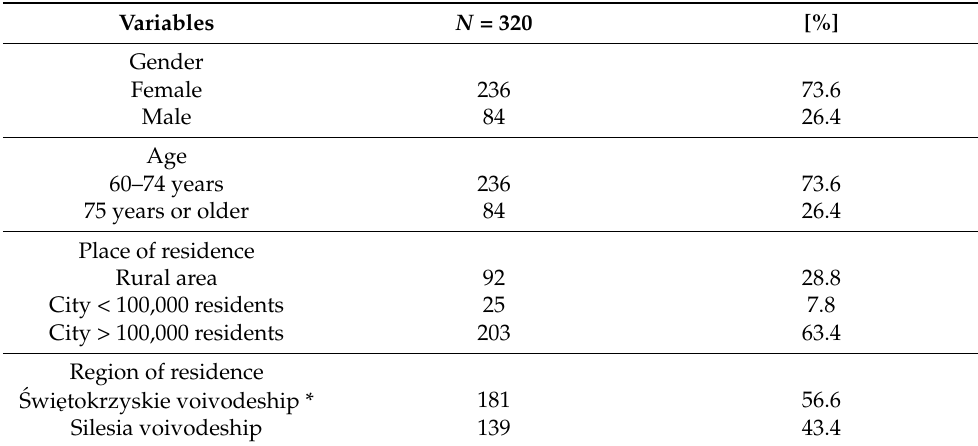
Table 2. Demographic characteristics of the